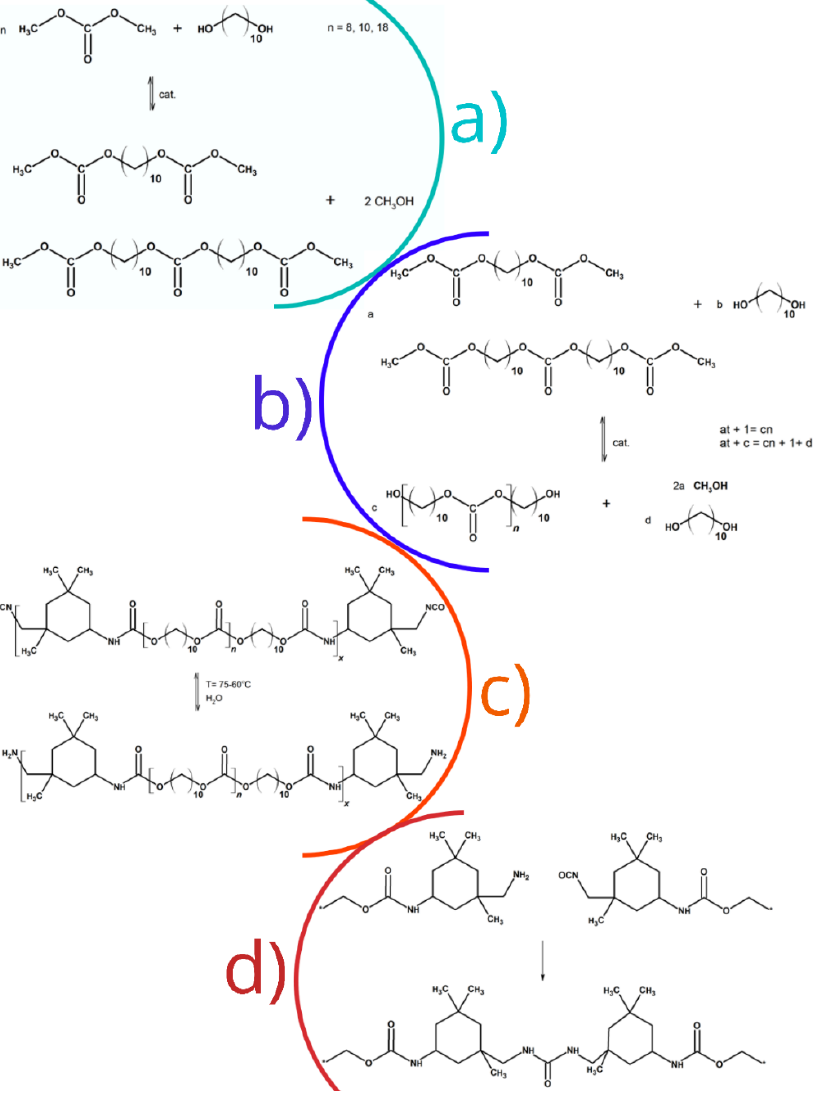
Figure 1. Synthesis steps of: ( a ) alkylene bis(methyl carbonate)s; ( b ) oligo(alkylene carbonate) diols; ( c ) urethane prepolymers; and ( d ) poly(carbonate-urethane-urea)s.